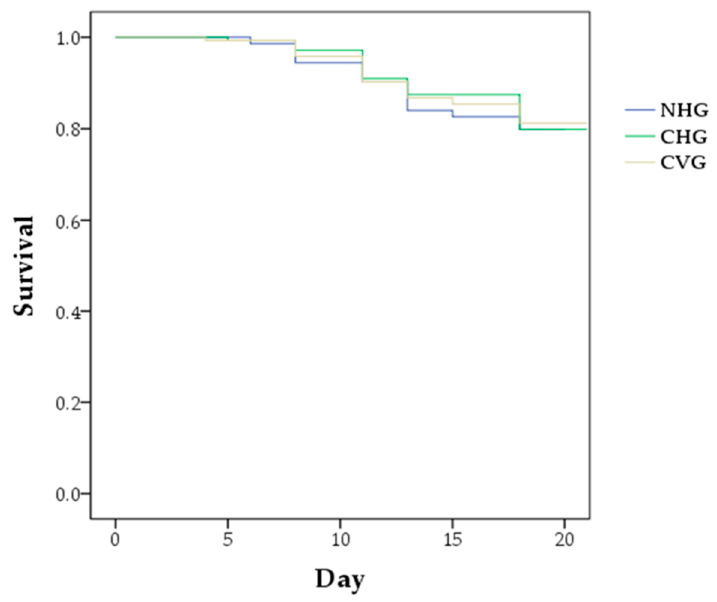
Figure 1. The survival curves of the honey-bee larvae of the horizontally oriented groups and the vertically oriented groups over 21 days, which were assessed by the Kaplan–Meier log-rank test ( p > 0.05). NHG: the non-capped and horizontally oriented groups; CHG: the capped and horizontally oriented groups; CVG: the capped and vertically oriented groups.